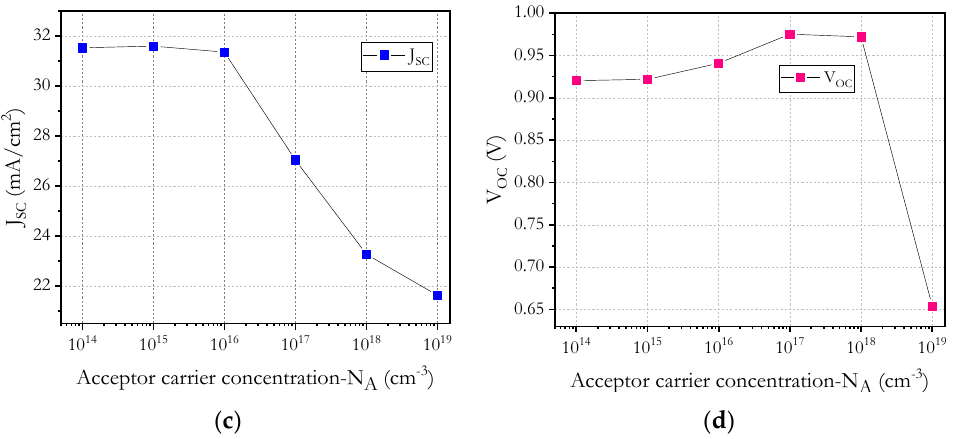
Figure 11. Acceptor carrier concentration ( N A ) in absorber layer versus: ( a ) FF , ( b ) PCE , ( c ) J sc and ( d ) V oc .